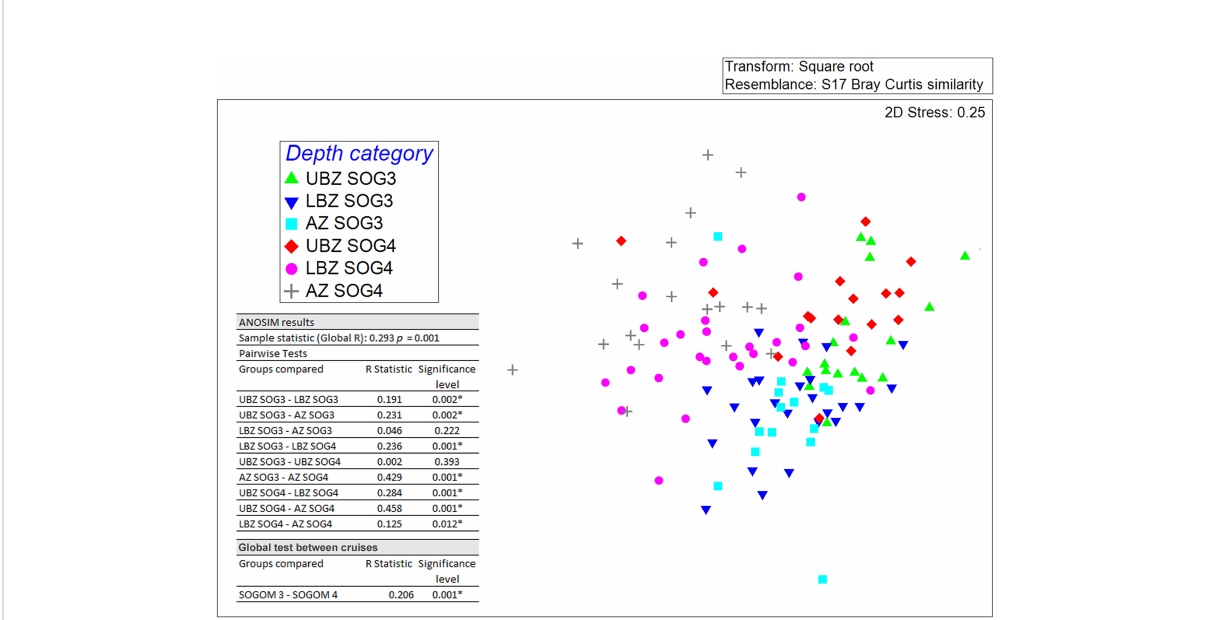
FIGURE 10 Non-metric multidimensional scaling of SOGOM 3 and SOGOM 4 macrofauna communities based on Bray Curtis similarities. Upper bathyal zone (UBZ), lower bathyal zone (LBZ), abyssal zone (AZ). UBZ in SOGOM 3 (green triangle), LBZ in SOGOM 3 (blue inverted triangle), AZ in SOGOM 3 (light blue square), UBZ in SOGOM 4 (red diamond), LBZ in SOGOM 4 (pink circle), AZ in SOGOM 4 (gray